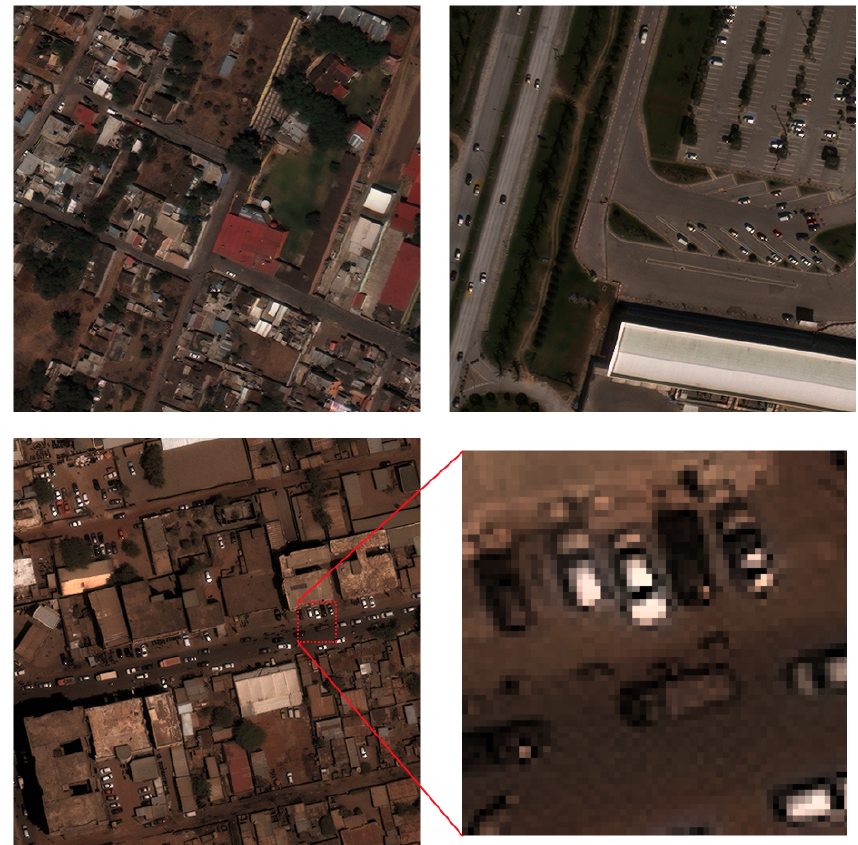
Figure 5. Examples of 30-cm resolution images in the XVIEW data [33].